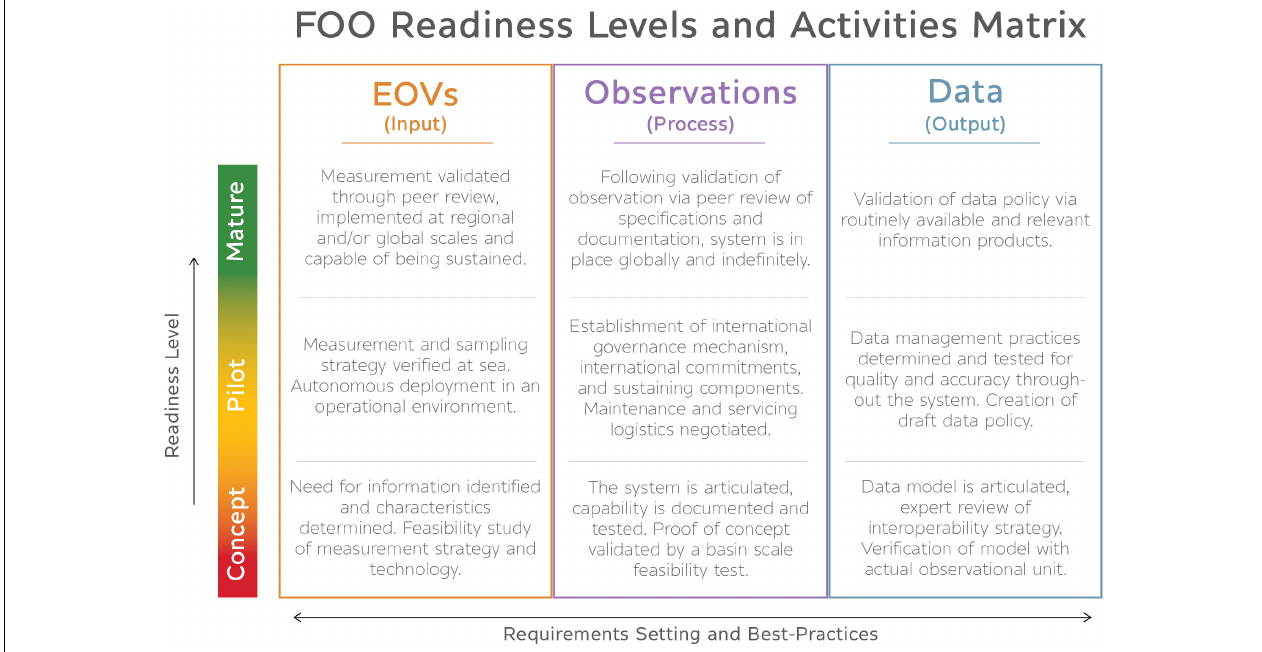
FIGURE 4 | Matrix of FOO-element attributes at increasing readiness levels.